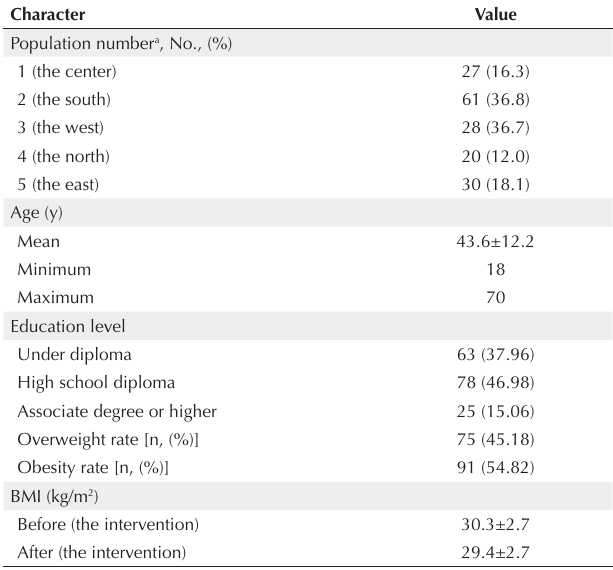
Table 2. Demographic Characteristics of Eligible Iranian Women Participating in the Urban HEART Intervention in Different Districts Character Value Population number a , No., (%)